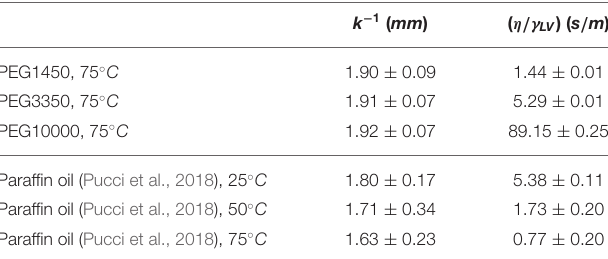
TABLE 3 | Capillary length and viscosity to surface tension ratio for polymers.